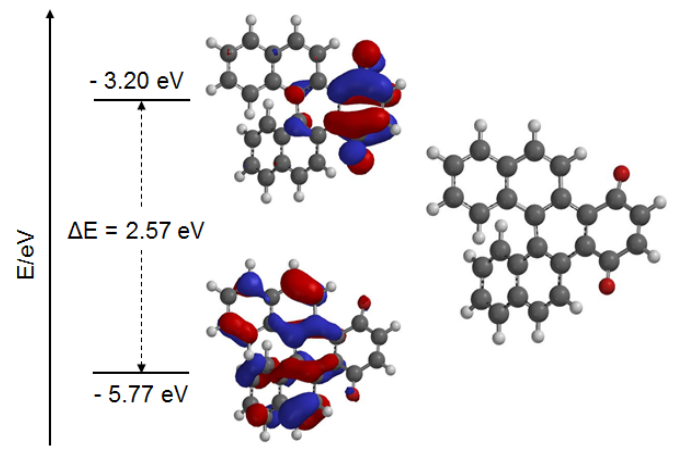
Figure 3. Computational (DFT) values of HOMO/LUMO/gap energies, MO electron density con- tours and structure of [5]helicenebenzoquinone.